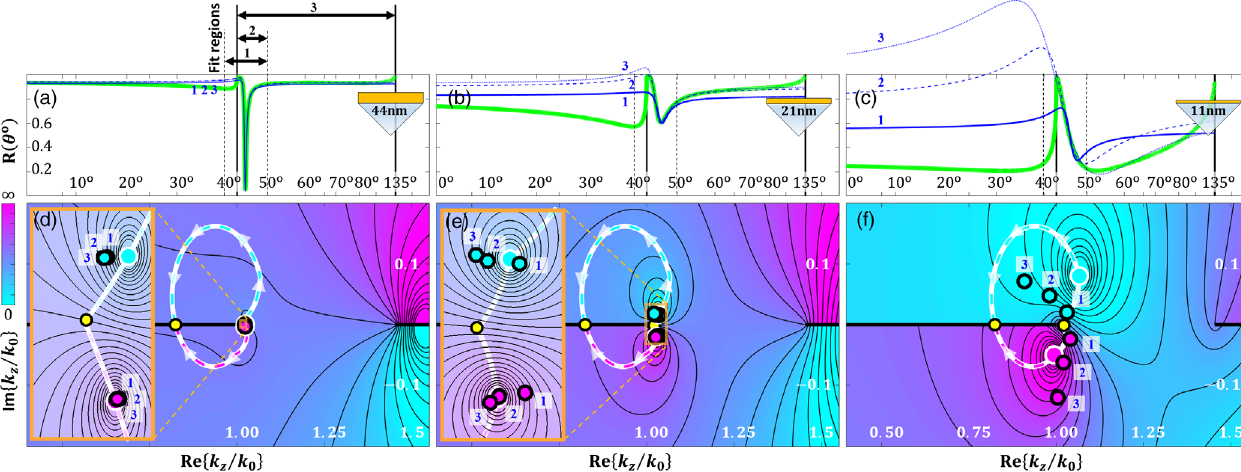
FIG. 11. Dependence of the Fano model on fitting range. Calculated reflectance of (a) 44, (B) 21, and (c) 11 nm gold films (green curve) at illumination wavelength λ ¼ 800 nm, compared to the generalized Fano line shape (blue curves) fitted over three incidence angle ranges (black arrows): the range covered in our experiment (solid curve, noted 1), the subset of the former lying above the critical angle (dashed curve, noted 2), and the entire angular range accessible above the critical angle (dotted curve, noted 3). (d) – (f) The field amplitude reflection coefficient r calculated over the complex wave-vector range k z corresponding to the angular range and film thicknesses in (a) – (c), showing the exact reflection pole (magenta) and zero (cyan) wave vectors (white circles) over their closed-loop trajectory (white curve), compared to the fitted pole and zero wave vectors (black circles) extracted from the Fano model fitted over the angular ranges 1 – 3. Enlarged sections are highlighted by orange rectangles. For a genuine comparison, the reflectance R ð θ Þ in (a) – (c) equals j r ð k z Þj 2 and is not corrected for partial transmission at the entry and exit from the coupling